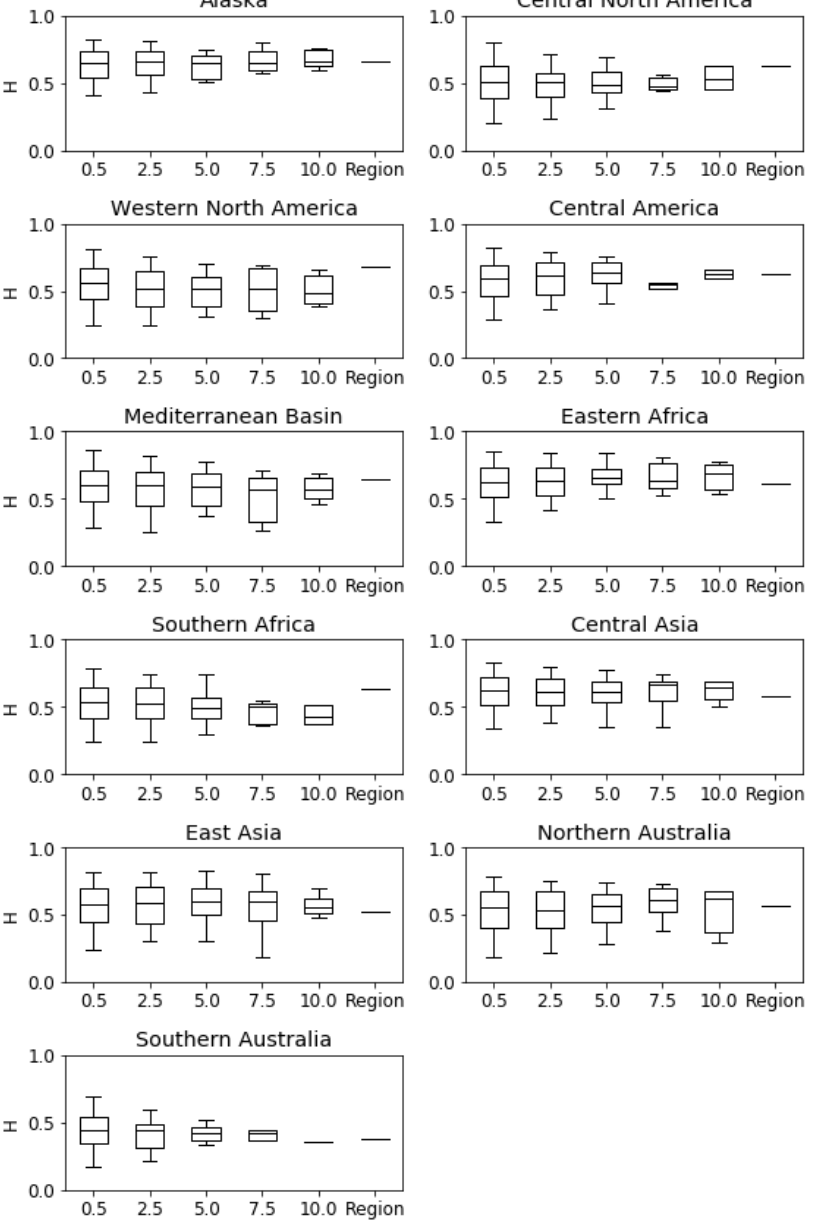
Figure 4. Box plots showing scale dependence of H for the 11 selected regions. Units for x -axis are decimal degrees.